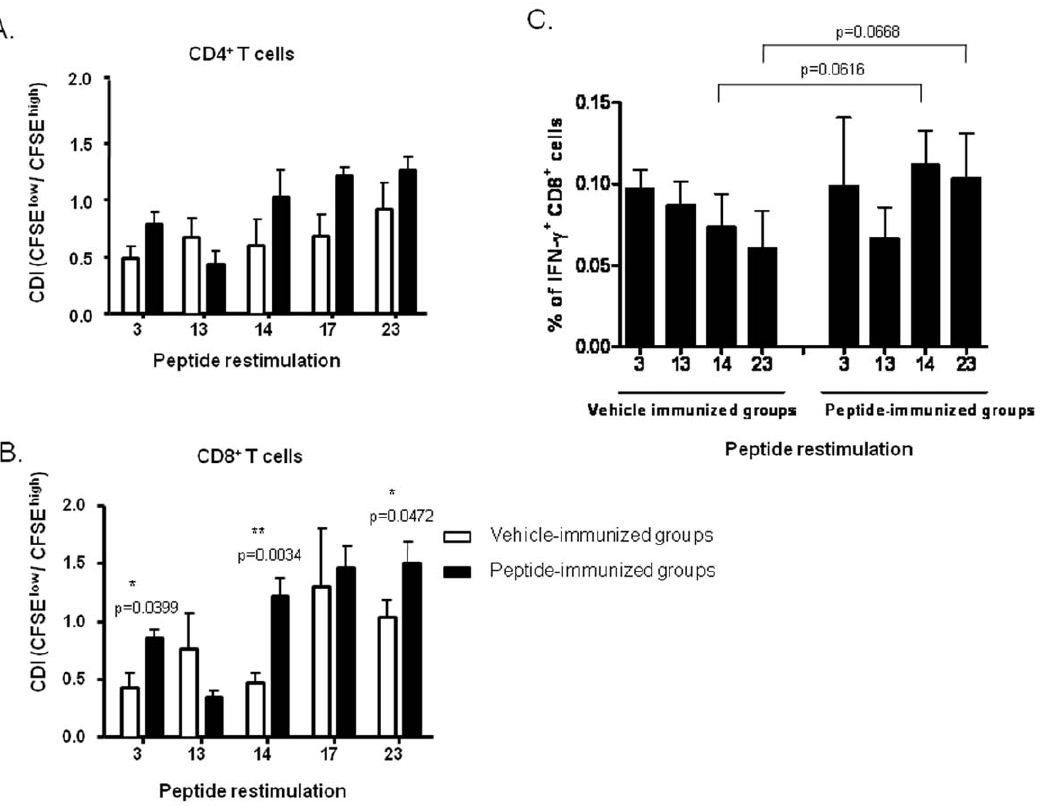
Figure 2. Epitope-specific CD4 + and CD8 + T-cell activation in peptide-immunized HLA-A*0201 transgenic mice. Splenocytes were isolated on day 17 from mice immunized twice subcutaneously with the peptides 3, 13, 14, 17, 23, or vehicle at day 0 and day 10. The splenocytes were labeled with CFSE and cultured in the presence or absence of 10 m g/mL of the respective peptides for 8 days. Proliferation of CD4 + (A) or CD8 + (B) lymphocytes in response to the different CD8 epitopes was analyzed by flow cytometry using anti-CD4 or CD8 antibodies conjugated with PE-Cy5. Results are presented as cell division index (CDI) as described in the Materials and Methods. (C) The splenocytes were stimulated in vitro with or without the peptides and were stained with anti-CD8 antibody conjugated with FITC, and then fixed and stained for intracellular IFN- c using PE- conjugated anti-IFN- c antibody. The percentage of CD8 + IFN- c + T cells was calculated. *( p , 0.05) and **( p , 0.01) indicate they are significantly different from the unstimulated splenocytes. Data is representative of results derived from three independent experiments.